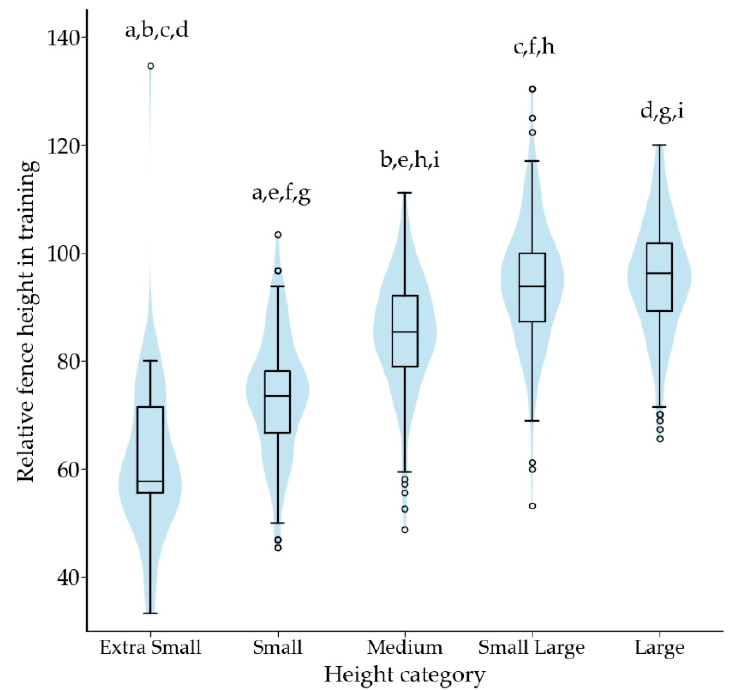
Figure 4. Box plot showing relative fence height in training according to the height category. Same letter indicates a significant difference between two height categories. For letter a, p < 0.05, and for letters b to i p < 0.001. Outliers are plotted as “ ◦ ”.